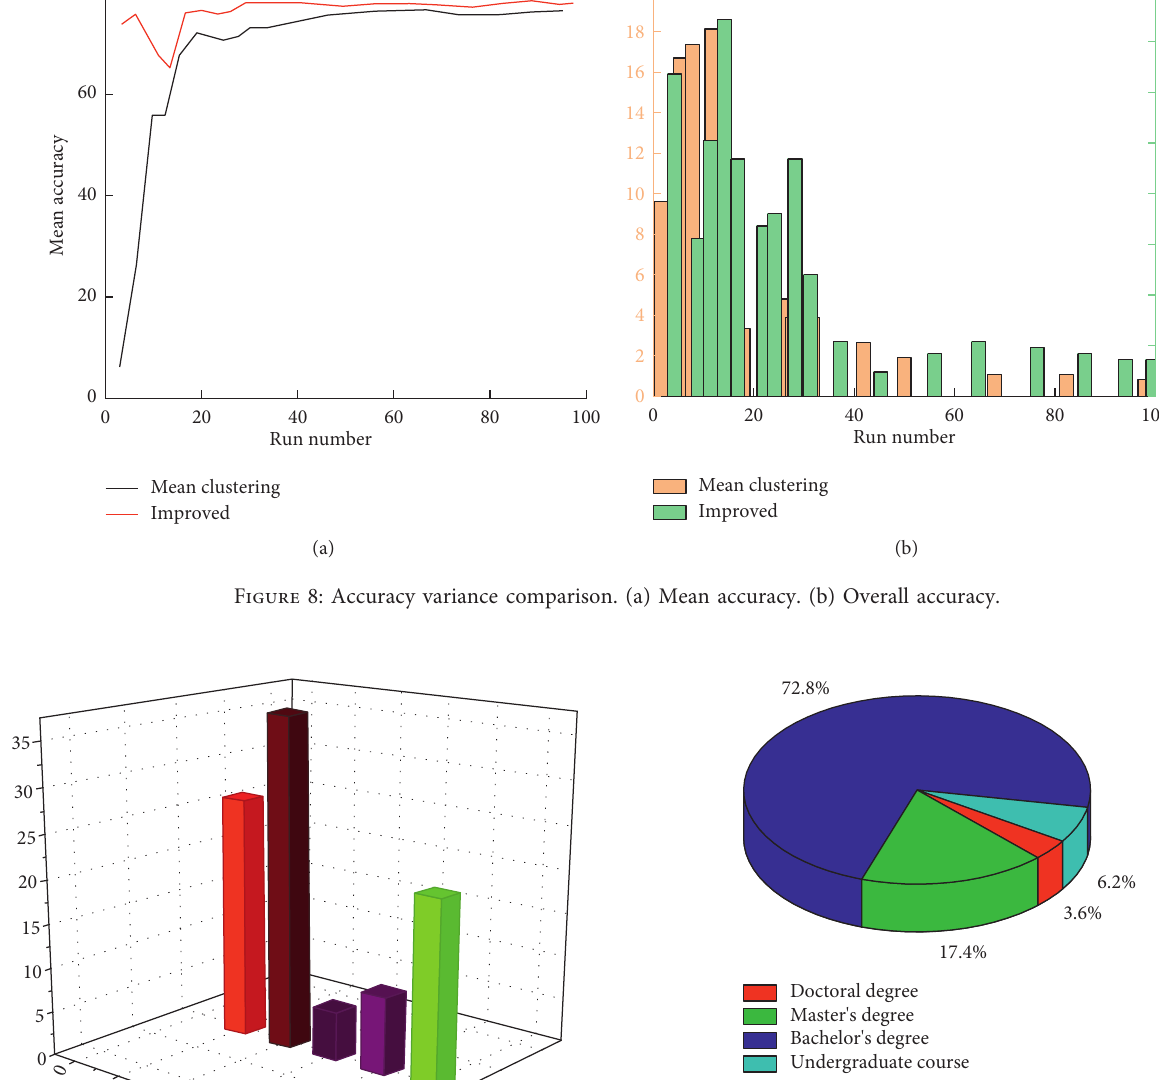
Figure 10: Employee’s educational background